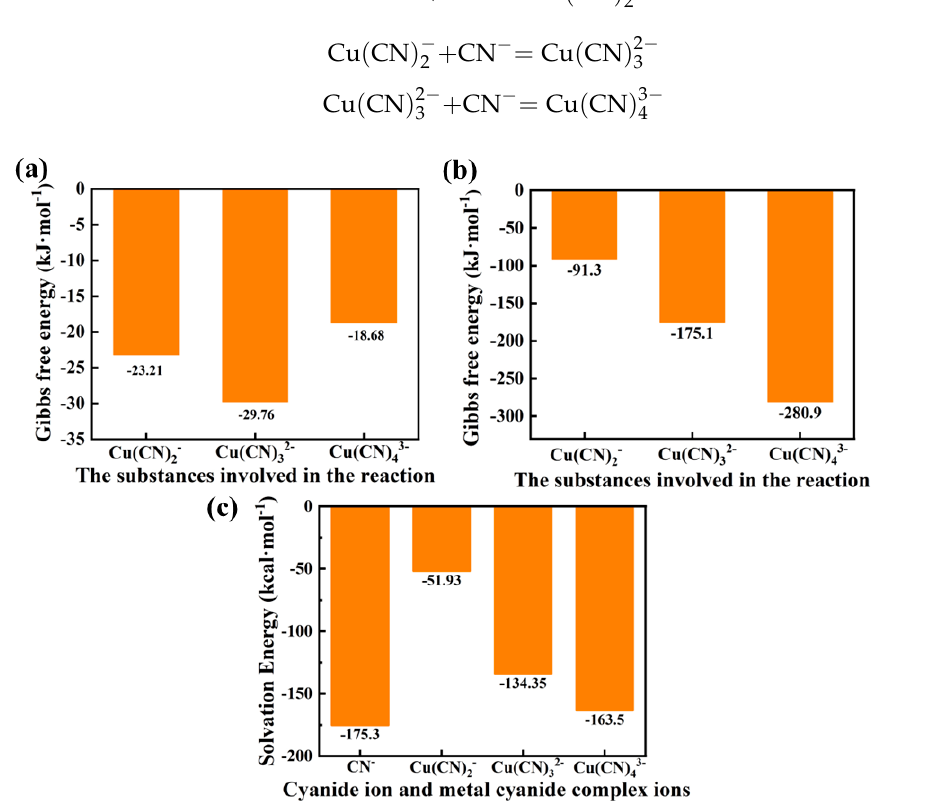
Figure 4. ( a ) The Gibbs free energy ( Δ G) of the chemical reactions involving Cu(CN) 2 − , Cu(CN) 32 − and Cu(CN) 43 − . ( b ) The Gibbs free energy ( Δ G) of the precipitation reactions involving Cu(CN) 2 − , Cu(CN) 32 − and Cu(CN) 43 − . ( c ) The solvation free energy of CN − , Cu(CN) 2 − , Cu(CN) 32 − and Cu(CN) 43 − .